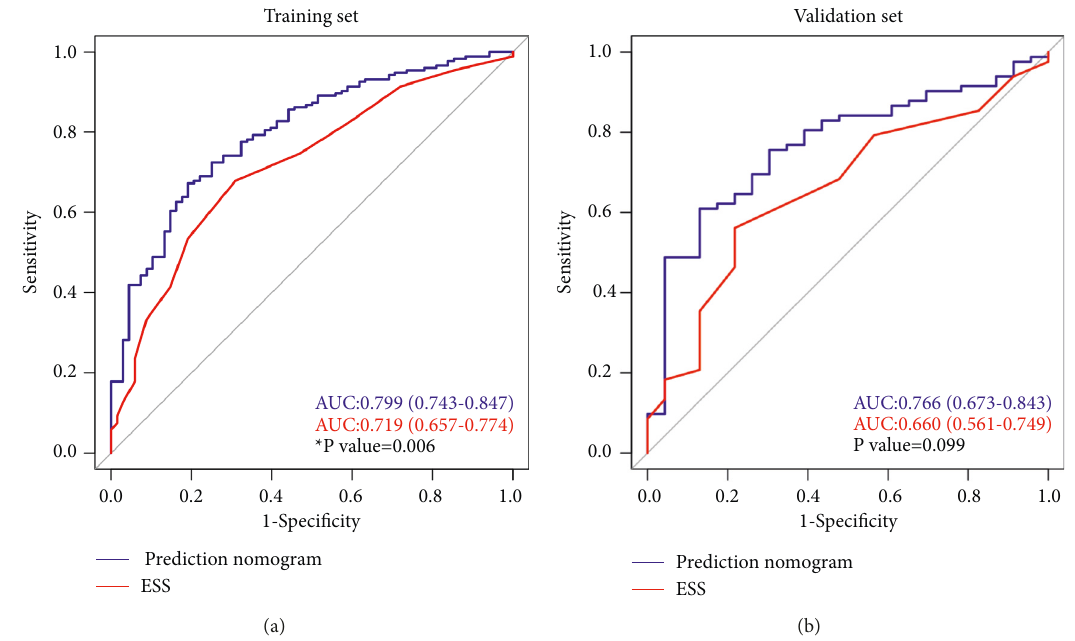
Figure 3: Receiver operating characteristic curve of the nomogram prediction and ESS in training set (a) and in validation set (b). The area under curve of the nomogram model is significantly larger than that of ESS. OSA, obstructive sleep apnea; ESS, Epworth sleepiness scale; AUC, area under the